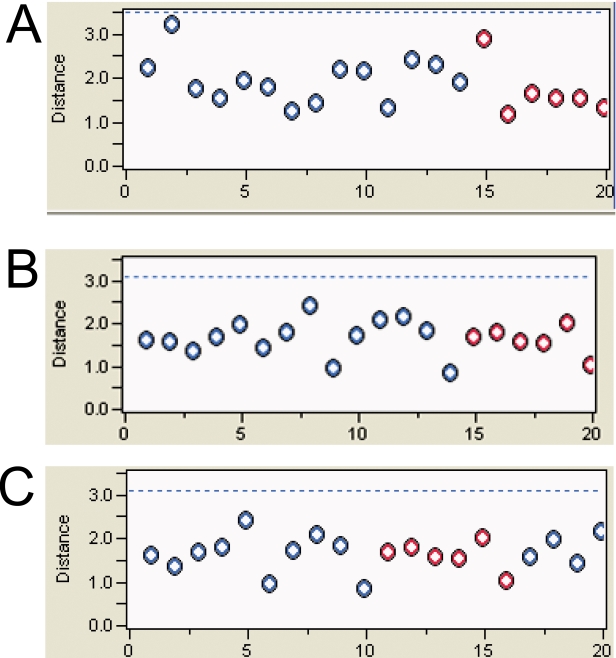
Comparison of Mahalanobis Distances of Gene Expression by Array Hybridization and Sequence Read Frequencies.14 SCZ samples are indicated by blue circles, and 6 control samples by red circles. The Y-axis shows Mahalanobis distances of log transformed gene expression values. The dotted blue line indicates the cutoff value for outliers. Panel A: Log10 transformed Affymetrix array hybridization signals. Panel B: Log10 transformed genome-aligned read frequencies. Panel C: Log10 transformed transcript-aligned read frequencies. Log10 transformed array hybridization values (A) had a wider distribution of distances than Log10 transformed sequence read frequencies (B,C). Without log transformation, distances were greater and several samples represented outliers (data not shown).